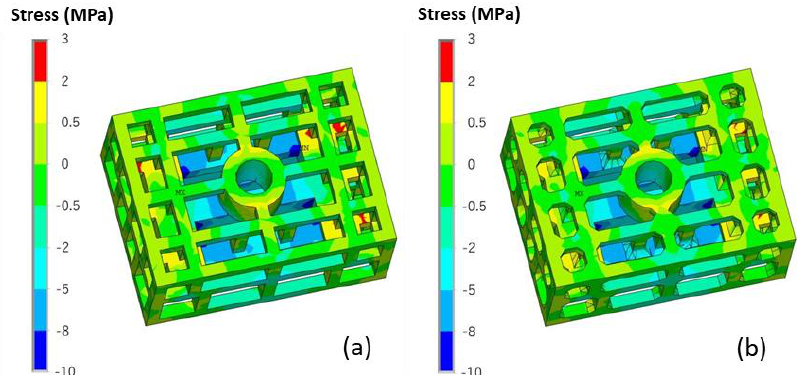
Figure 25. Comparison of the σ y stress of the skeletal sand mold at shakeout ( a ) without filleting and Figure 25. Comparison of the  y stress of the skeletal sand mold at shakeout (a) without filleting and Figure 25. Comparison of the  y stress of the skeletal sand mold at shakeout (a) without filleting and ( b ) with filleting. Figure 25. Comparison of the  y stress of the skeletal sand mold at shakeout (a) without filleting and (b) with filleting. (b) with filleting. (b) with filleting.